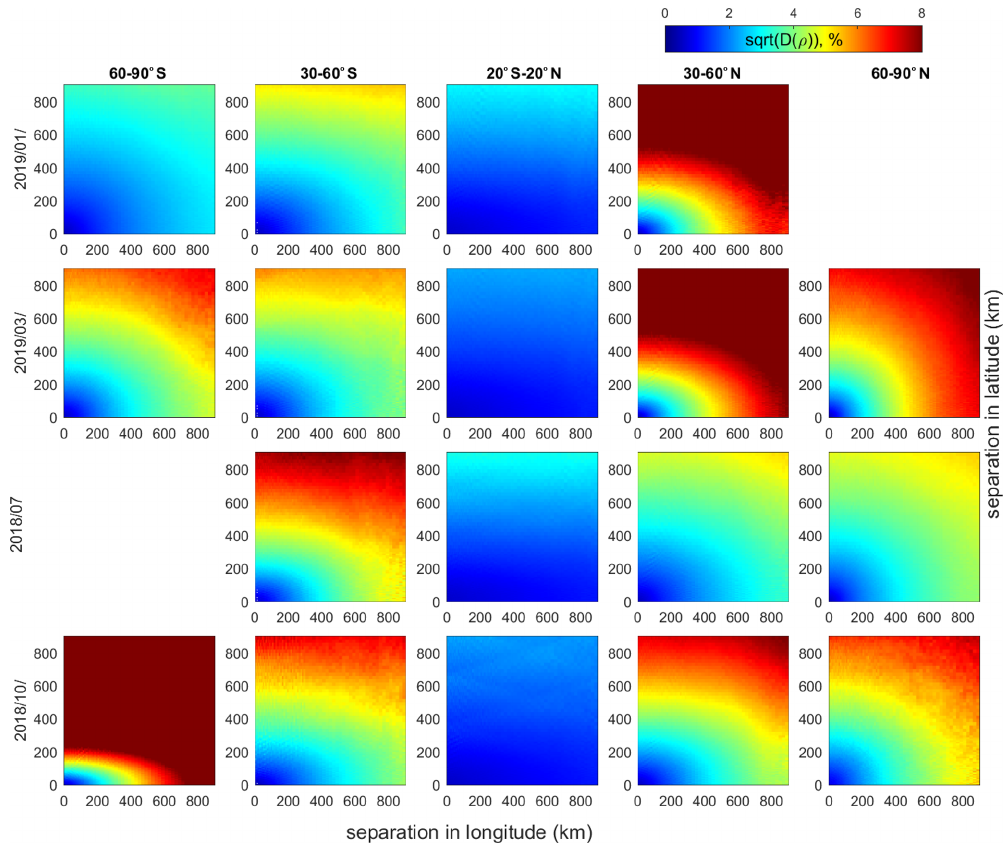
Figure A1. Structure function (in %) for different latitude bands (columns) and months